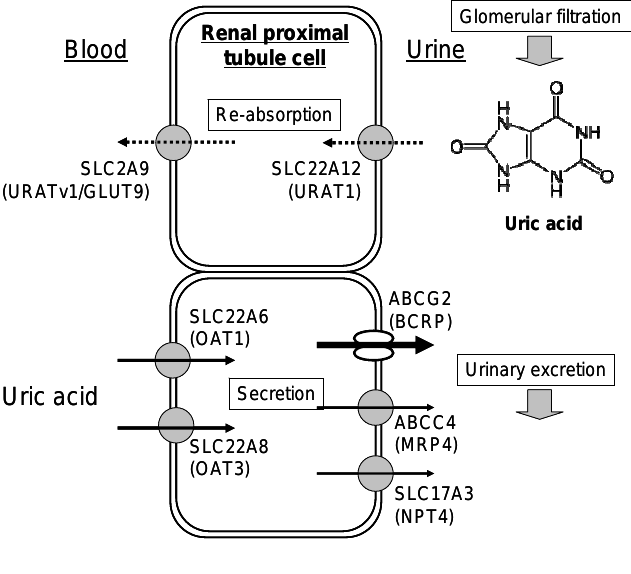
Figure 3. Schematic illustration of renal re-absorption and excretion of uric acid. Uric acid filtrated from the renal glomerular body is first re-absorbed by human renal proximal tubule cells. Thereafter, uric acid is eliminated, in part, from the blood circulation to urine by renal transporters. Arrows in the figure indicate the direction of transport of uric acid. Dotted and solid lines indicate re-absorption and secretion,